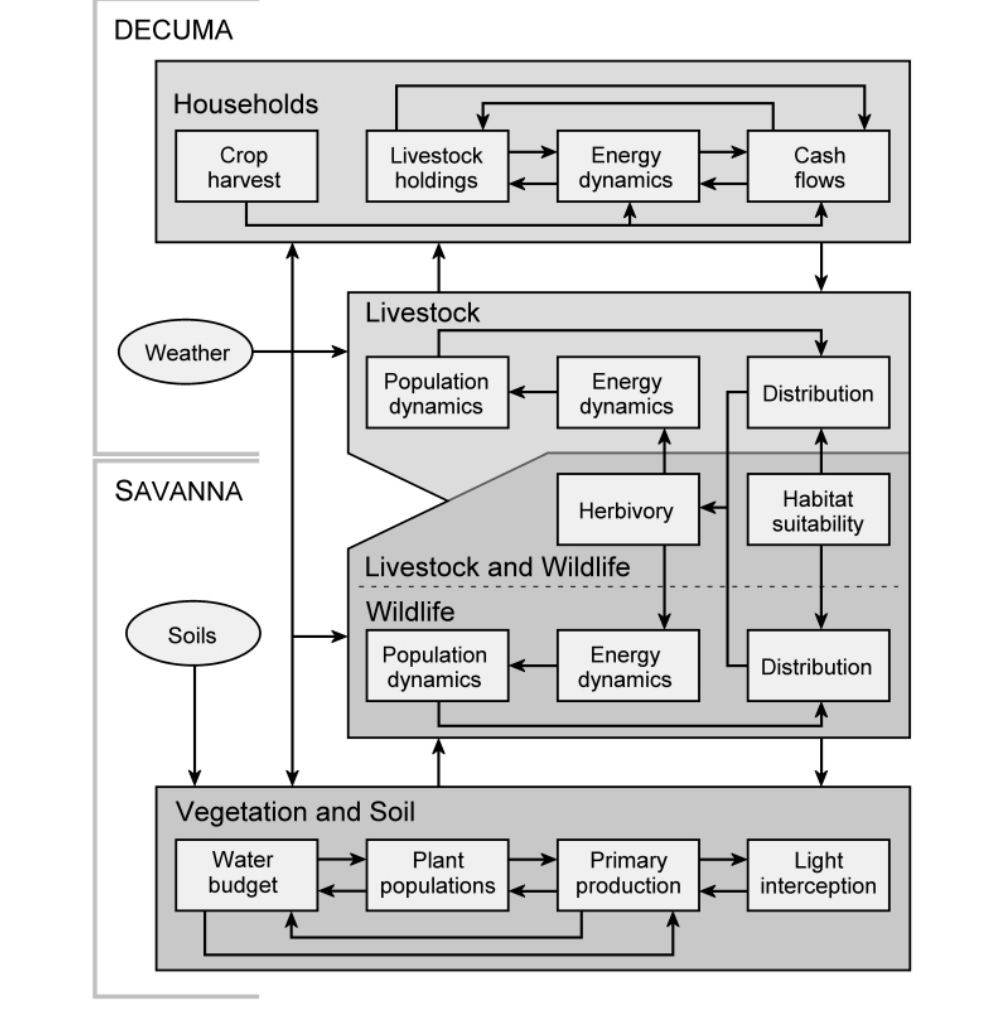
Fig. 2 . Primary information flows within the household decision-making model DECUMA and the ecosystem model SAVANNA, and flows between the models. See the Methods for a discussion of these